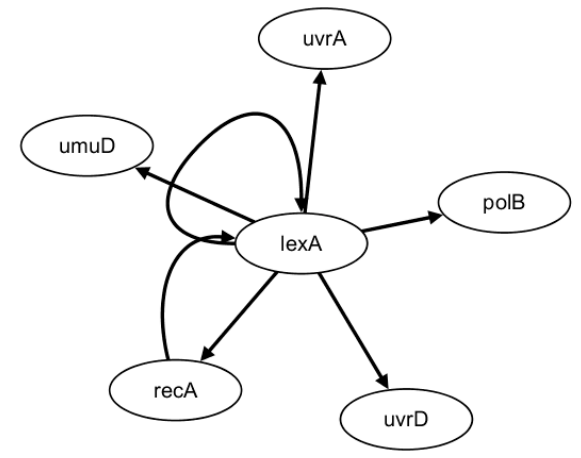
Figure 2. E. coli SOS DNA repair network .